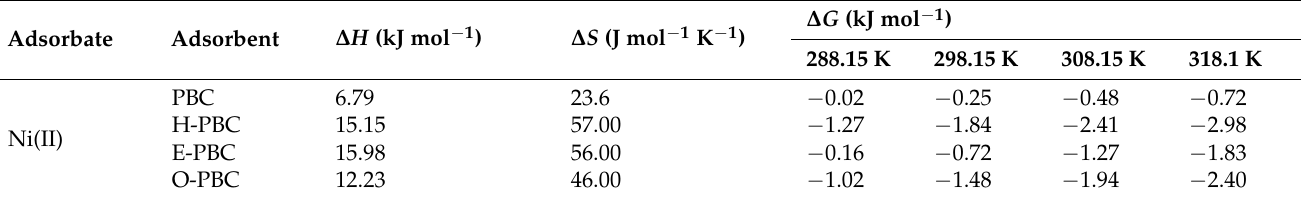
Table 2. Thermodynamic parameters for the adsorption of Ni(II) by PBC, H-PCB, E-PBC, and O-PBC at different temperatures.